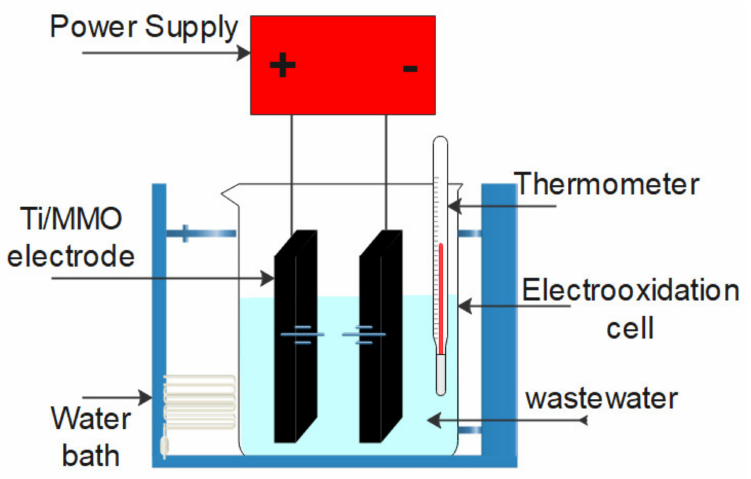
Figure 1. A schematic diagram for an electrochemical oxidation (EO) process.